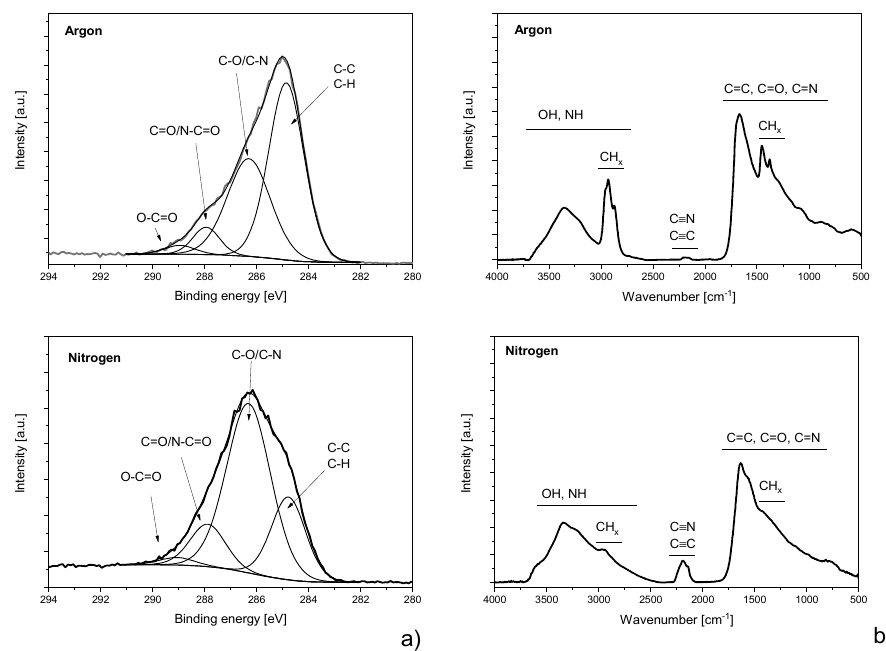
Figure 4. ( a ) High-resolution X-Ray Photoelectron Spectroscopy (XPS) spectra of C 1s peak of NPs deposited in Ar (top) and N 2 (bottom) measured by XPS (Phoibos 100, Specs) with an Al K α X-ray source (1486.6 eV, 200W, Specs). ( b ) Fourier Transform Infrared Spectroscopy (FT-IR) spectra of NPs deposited in pure Ar (top) and N 2 (bottom) recorded by FT-IR (Bruker Equinox 55) in a reflectance-absorbance mode using gold-plated silicon wafers as substrates. Table 1. Elemental composition of C:H:N:O NPs deposited using Ar or nitrogen and relative contributions of different bond types, resulting from spectral de-convolution of C 1s peak. Working Gas O